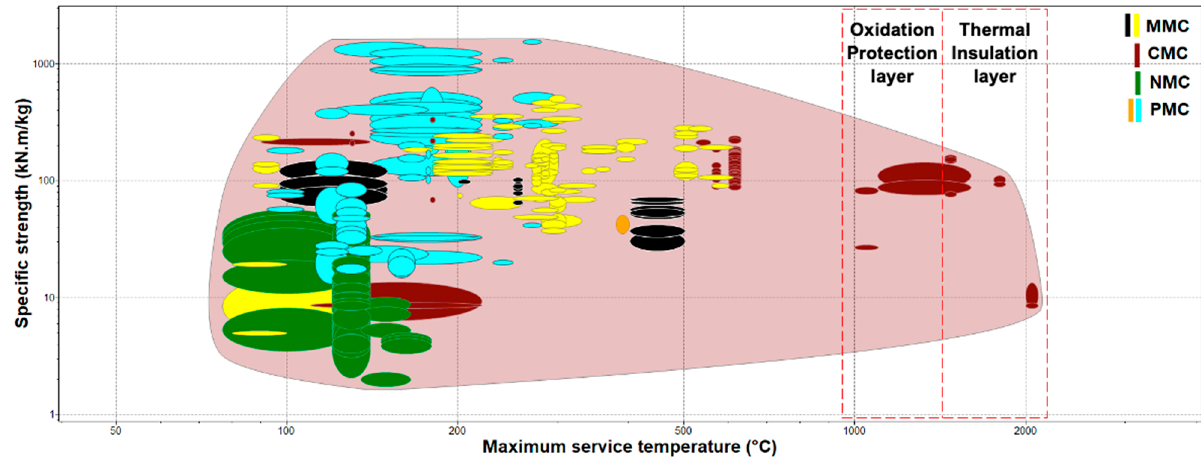
Figure 22. CMC material performance against other composite matrices.